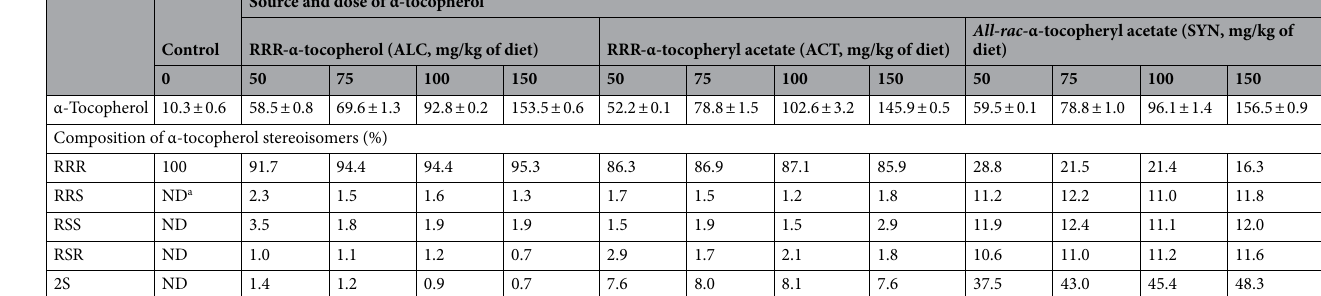
Table 1. α-Tocopherol content and distribution of stereoisomers in the different experimental diets (Means ± SD). a ND, Not detected. 2S = Summation of 2S configuration of α-tocopherol